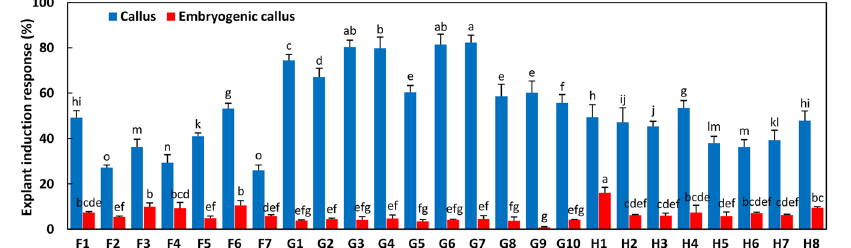
Figure 7. Effect of mother tree genotype on callus and embryogenic callus induction. Duncan's new multiple range test was used to detect differences at P < 0.05.